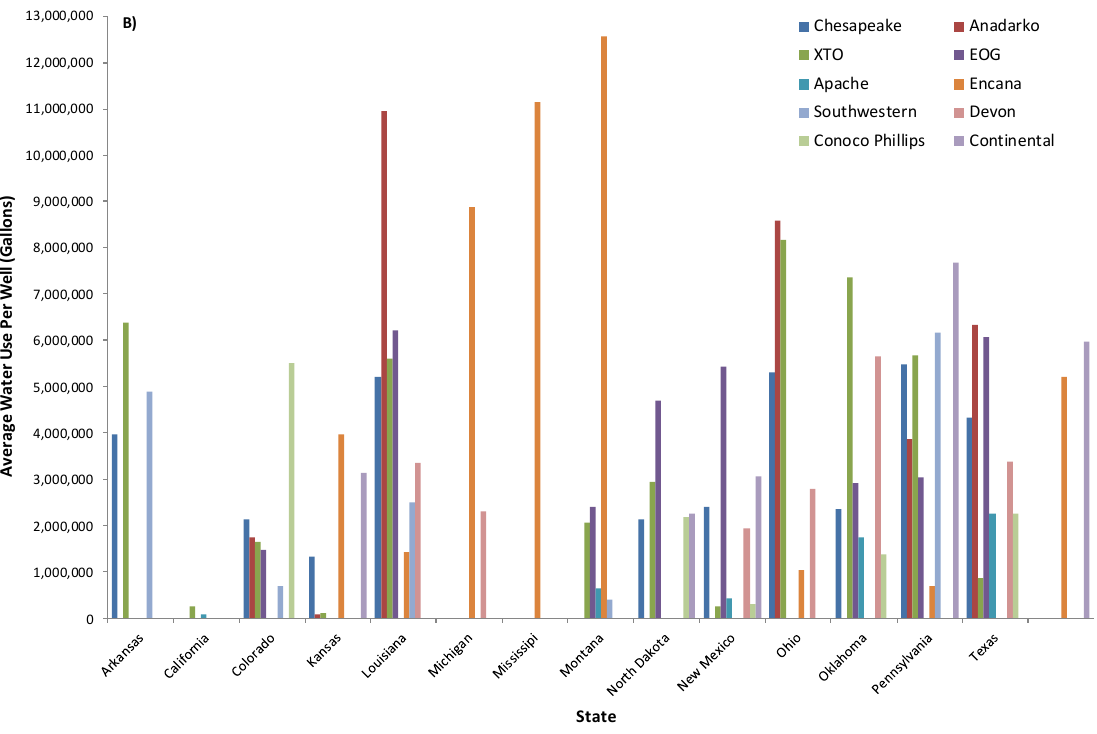
Figure 1. ( A ) Average Hydraulically Fractured Oil & Gas Well Water Demand Per Well across ten companies and six water stress environments and ( B ) fourteen US States and the aforementioned ten companies.